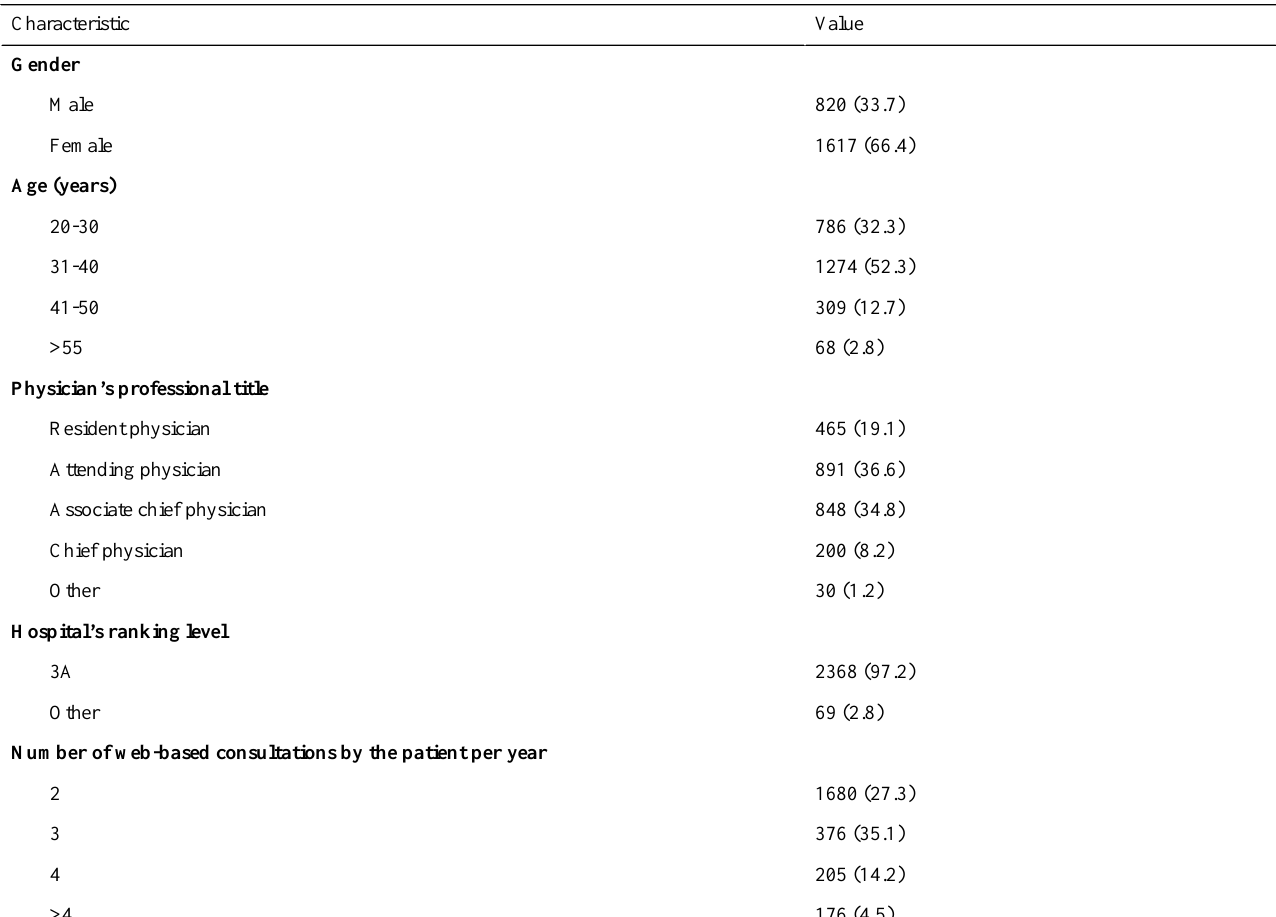
Table 2. Summary of the characteristics of the collected data records (N=2437), n